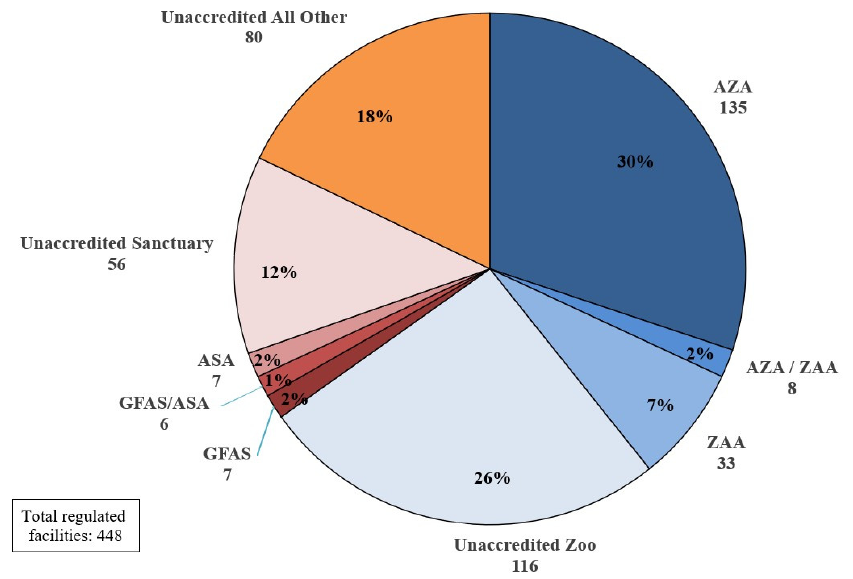
Figure 2. Federally regulated facilities holding big cat species sorted by accreditation. Note: Both the AZA and the ZAA accredit a small number of non-zoo facilities